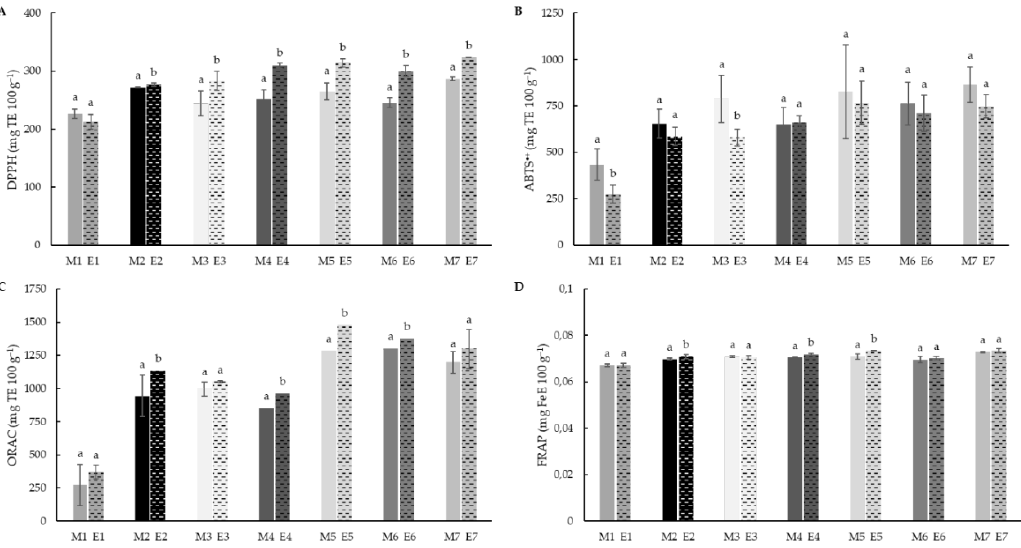
Figure 5. DPPH ( A ), ABTS • + ( B ), ORAC ( C ) and FRAP ( D ) values of native (M1-M7) and extruded (E1-E7) blend flour samples. The DPPH, ABTS and ORAC values are expressed as mg Trolox equivalent (TE) 100 g − 1 of dry matter, and FRAP values as mg ferric reduced equivalent (FeE) 100 g − 1 of dry matter. Different letters indicate significant differences ( p < 0.05) between non-extruded (M) and extruded (E) flours, for each blend formulation. M1/E1(100RF), M2/E2 (12.5WTF/12.5 BTF/75RF), M3/E3 (25WTF/75RF), M4/E4 (25BTF/75RF), M5/E5 (25WTF/25 BTF/50RF), M6/E6 (50WTF/50RF), M7/E7 (50BTF/50RF).